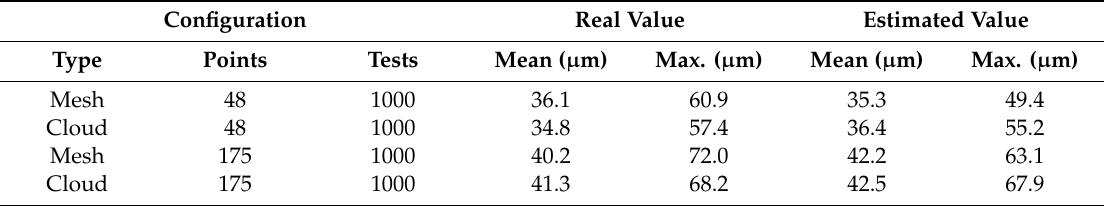
Table 3. Adequacy of Sche ffl er regression functions for the average and maximum error values.